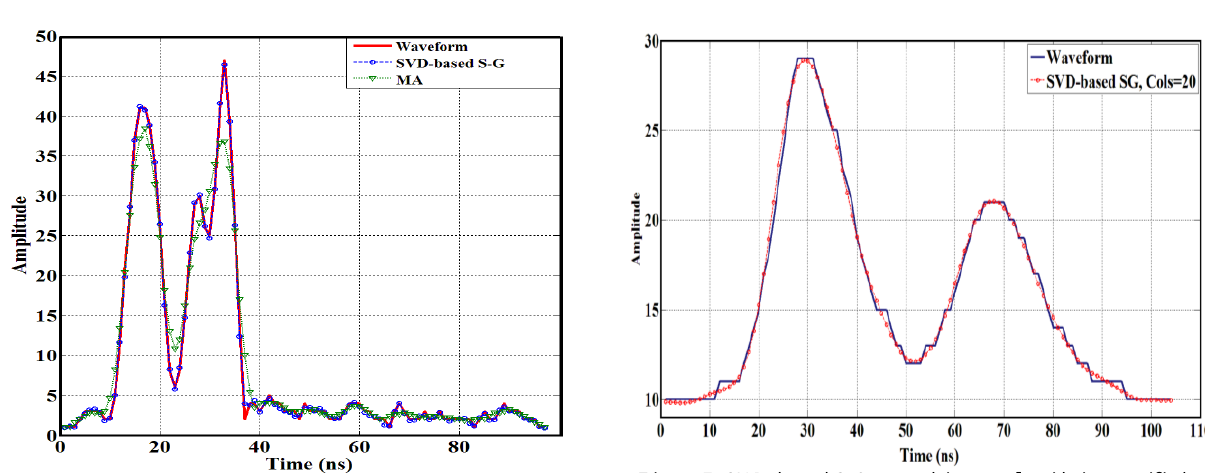
Figure 7. SVD-based S-G smoothing result with its specified number of columns of the Hankel matrix